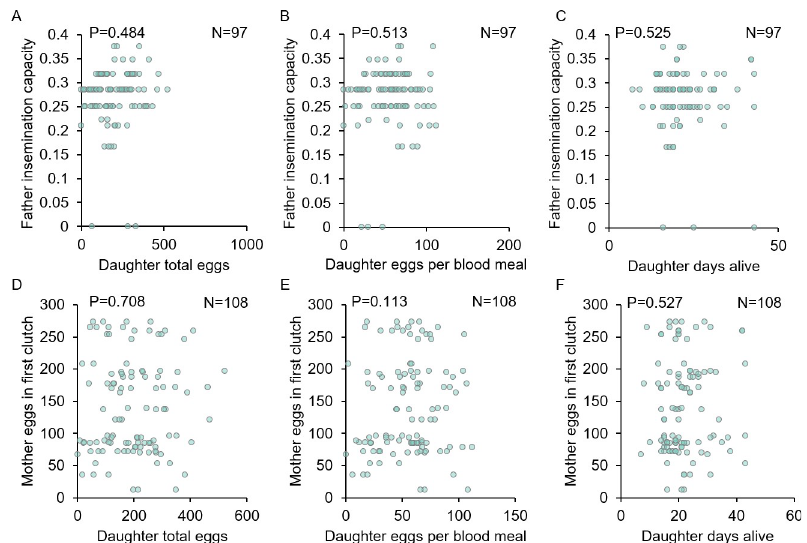
Fig 6. Parent reproductive fitness traits do not correlate with daughter lifetime fecundity or life history traits. Neither father fertility (A–C; P � 0.484 for all comparisons) nor mother fecundity (D–F; P � 0.113 for all comparisons) correlated with daughter fecundity or longevity. Graphs display correlation sample sizes (N) and LMM P-values for each comparison. For detailed statistics, see S1 Statistics.